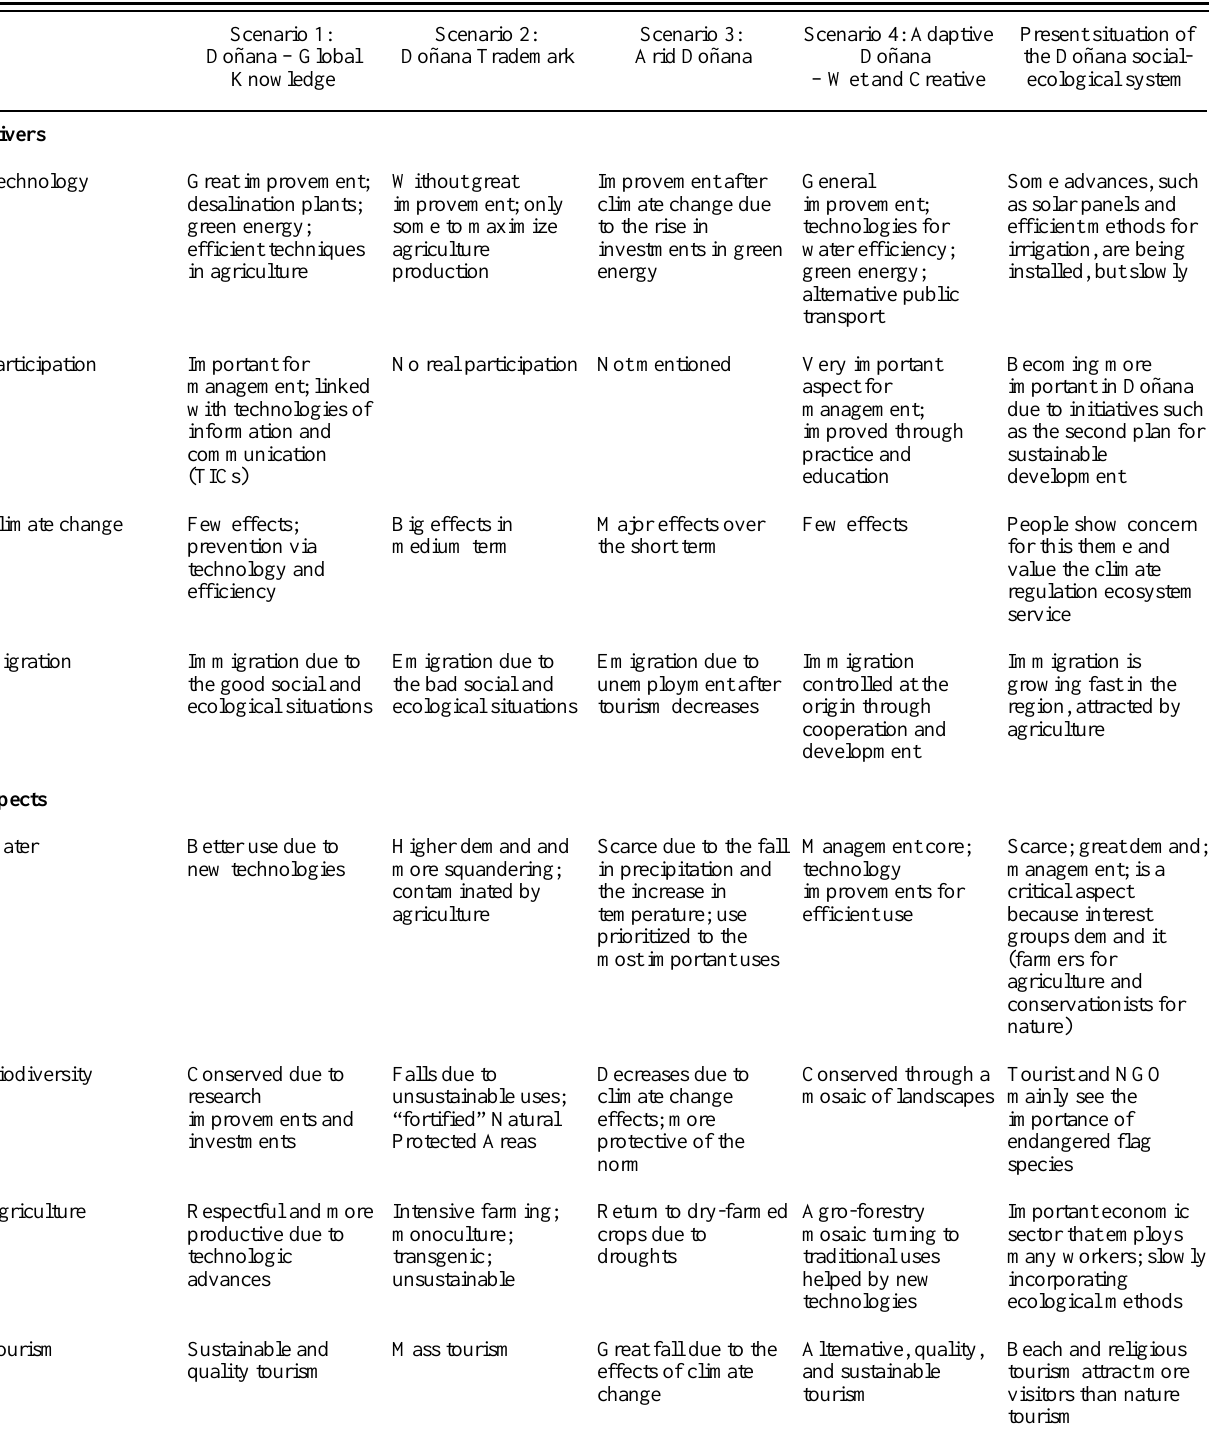
Table 2 . Main differences between scenarios attending to drivers, aspects, and social actors. The final column refers to the current situation of the Doñana social-ecological system, to allow the scenarios to be compared with the present